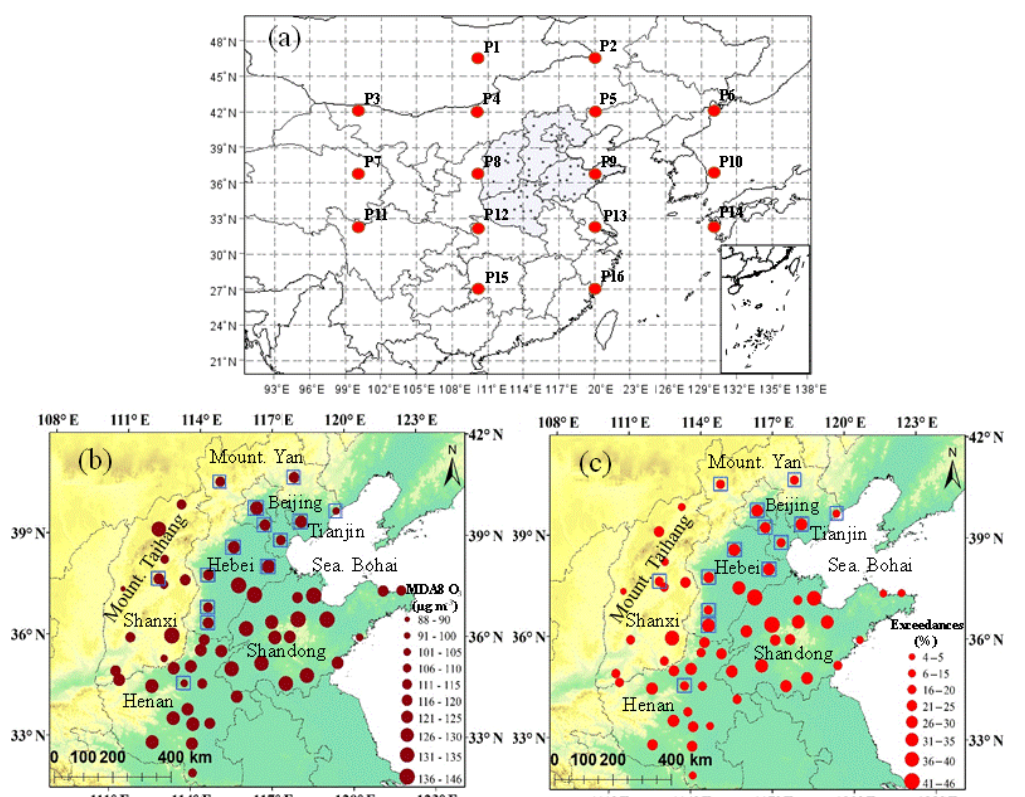
Figure 1. Location of northern China (shaded area), all cities (black dots) and sea level pressure grids (a) . The 16 red points show the locations of the 5 ◦ × 10 ◦ mean sea level pressure grids used for the Lamb–Jenkinson weather type classification. The spatial distributions of the maximum daily 8h running average O 3 (MDA8 O 3 ) concentration (b) and exceedance ratios (c) for 58 cities. Statistics for 2013–2017 are shown in blue boxes; the other boxes are those for 2015–2017. The base map is topography; the elevation of the Taihang Mountains is more than 1200m, and the Yan Mountains range from 600 to